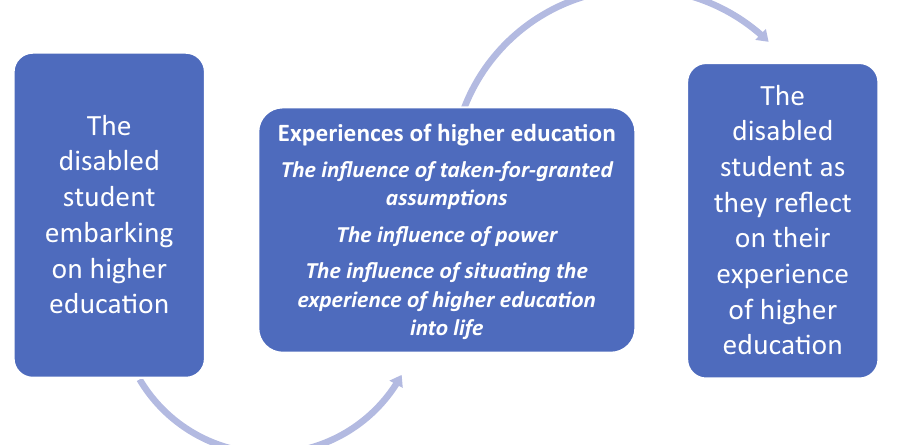
Figure 1. The way social theory can be used to understand a disabled student